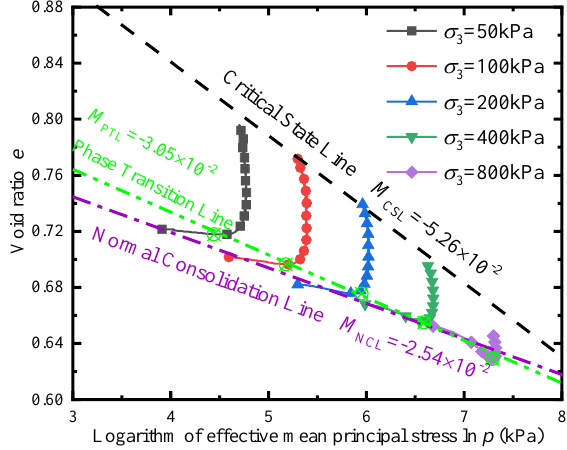
Figure 12. e- ln p relationships under drained conditions. Figure 12. e -ln p relationships under drained